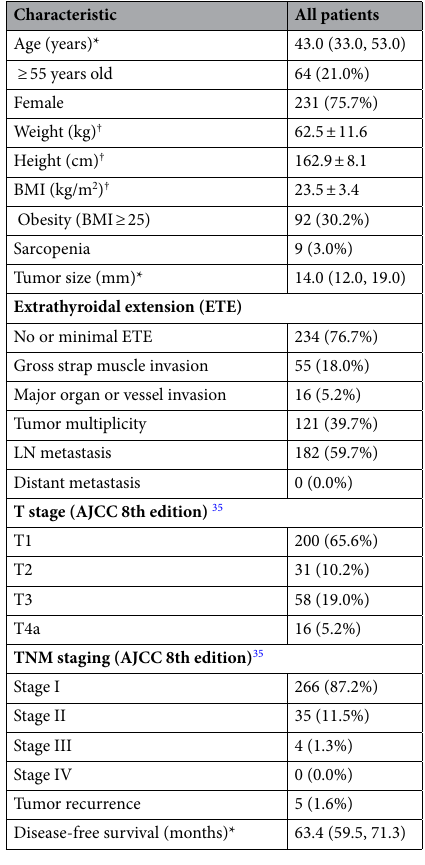
Table 1. Clinicopathologic characteristics of the study population. Data are presented as number of patients (percent) unless otherwise specified. *Data are presented as median (1st quartile, 3rd quartile). † Data are presented as mean ± standard deviation. BMI, body mass index; AJCC , American Joint Committee on Cancer; LN , lymph